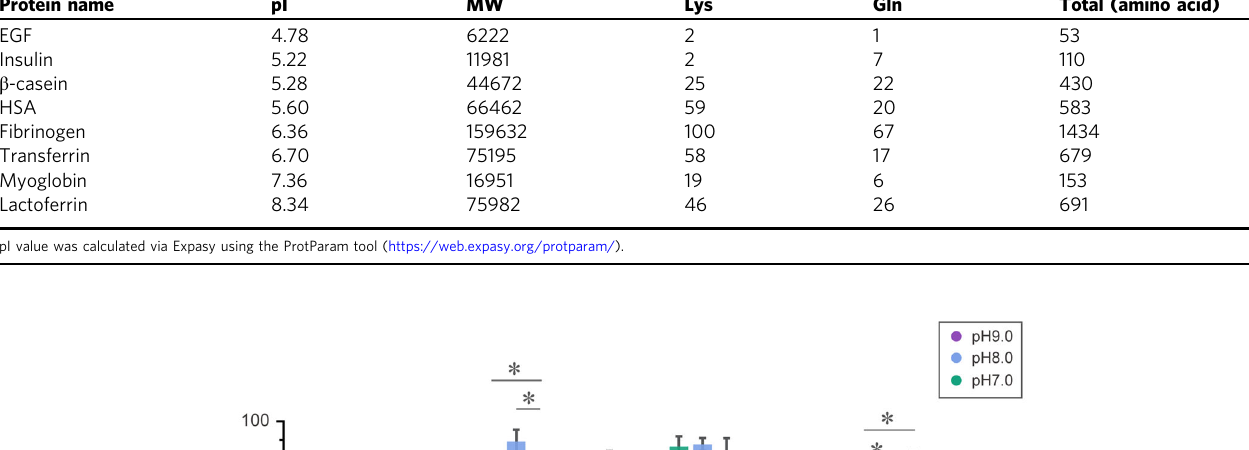
Table 2 Characteristics of model proteins used for evaluating the effect of pI value on the MTG-catalyzed conjugation reaction. Protein